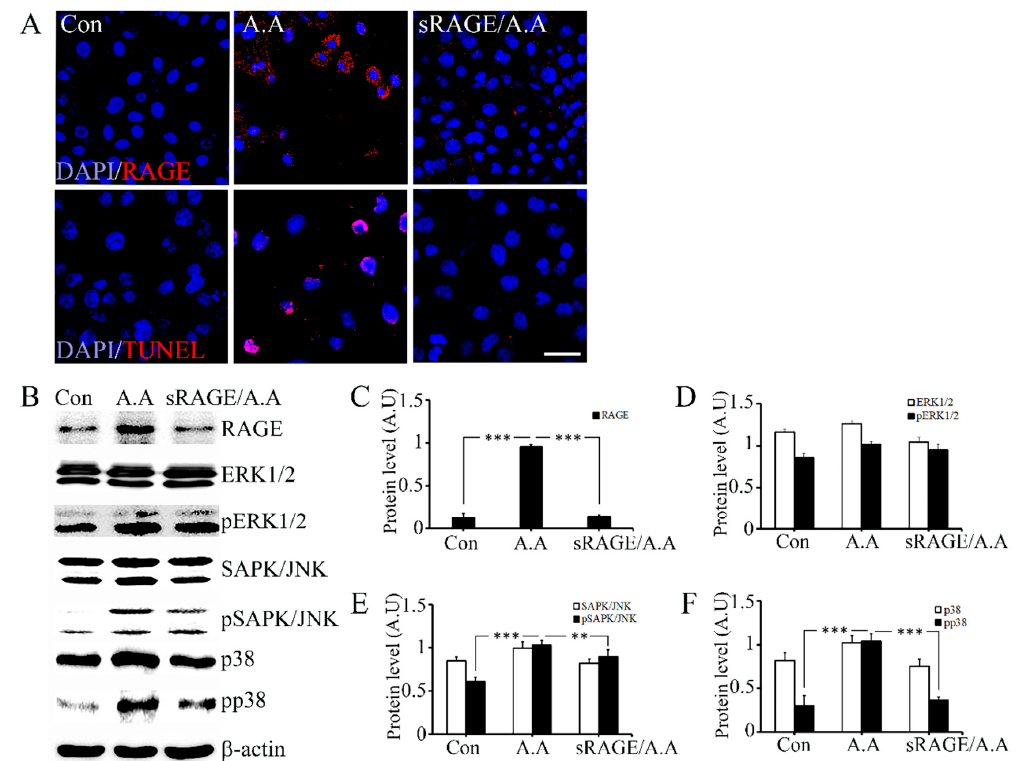
Figure 5. Protective effect of sRAGE on AGE-albumin-induced cardiomyocyte death by decreasing RAGE level. ( A ) RAGE expression is shown in double-labeled confocal images: RAGE (red) and DAPI (blue) using H9C2 cell before and after exposing AGE-albumin or co-treated with AGE-albumin and sRAGE. Cardiomyocyte cell death was evaluated by double staining with TUNEL (red) and DAPI (blue). ( B ) Immunoblot analysis of cardiomyocytes lysates after AGE-albumin or AGE-albumin with sRAGE co-treatment. RAGE expression was increased after AGE-albumin treatment but decreased after co-treatment with sRAGE. In MAPK analysis, pp38 and pSAPK/JNK were increased after AGE-albumin treatment but decreased after co-treatment. ( C — F ) Densitometry analyses of MAPK proteins were evaluated using the Image-J software. Scale bar = 50 μ m; **, p < 0.01; ***, p < 0.001.